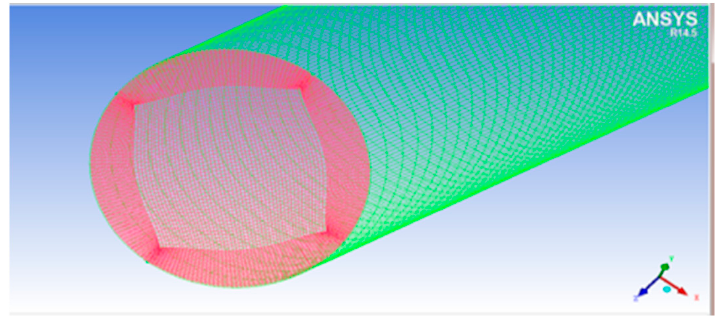
Figure 6. The unstructured meshes of the draft tubes (inlet and outlet pipes).